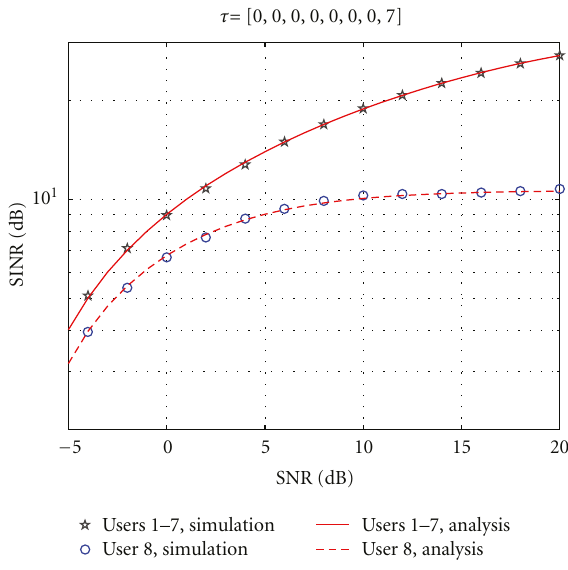
Figure 2: SINR versus SNR, τ 1 = τ 2 = ··· = τ 7 = 0, τ 8 = 7.